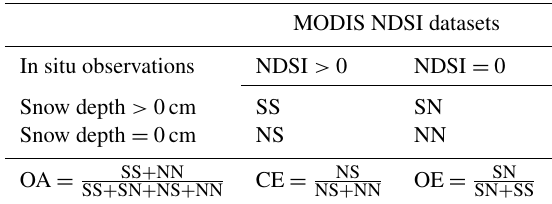
Table 4. Confusion matrix and validation